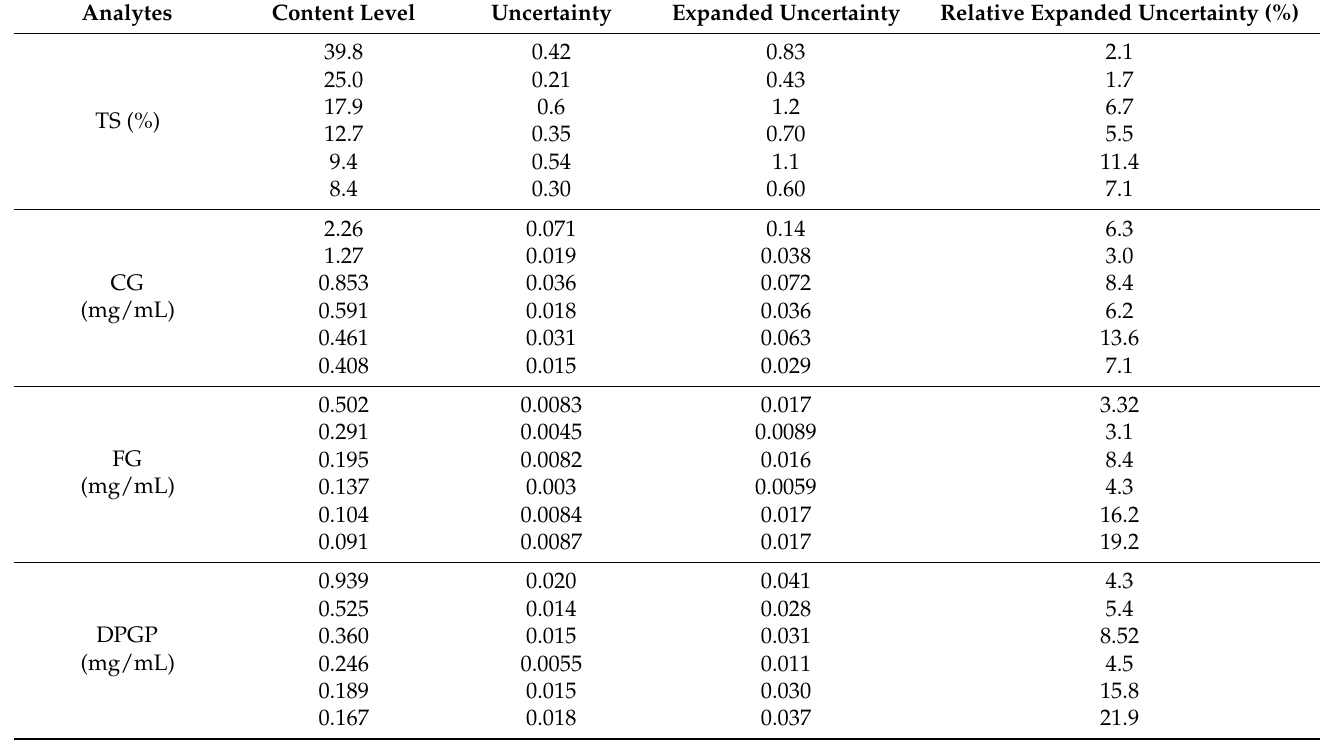
Table 9. NIR method uncertainties for the 7 analytes.